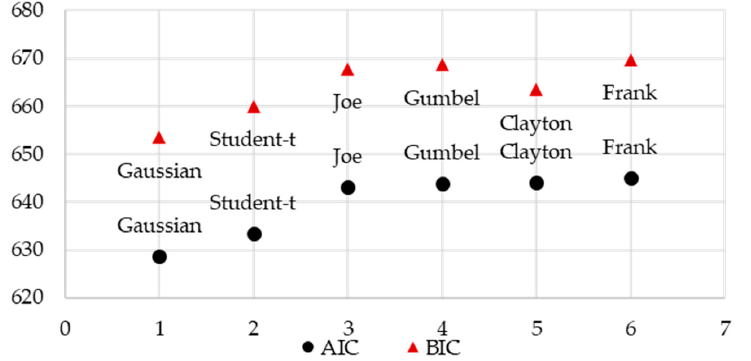
Figure 5. AIC and BIC for each copula-based meta-frontier production. Source: Own calculation.